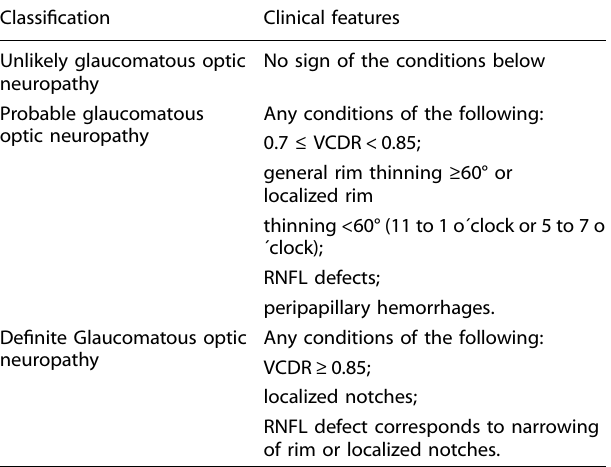
Table 4. Classi fi cation for glaucomatous optic